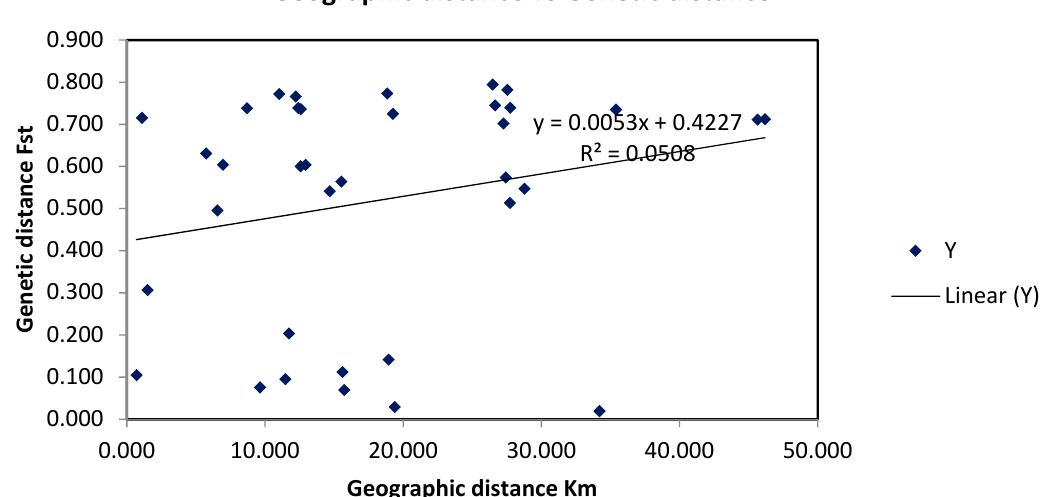
Figure 4. Mantel’s test for the correlation between Fst genetic distance and geographic distance (km) (R 2 = 0.0508; P < 0.05).